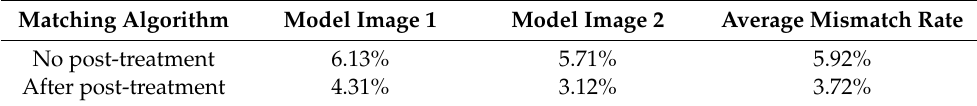
Table 5. Matching error rate of parallax images before and after